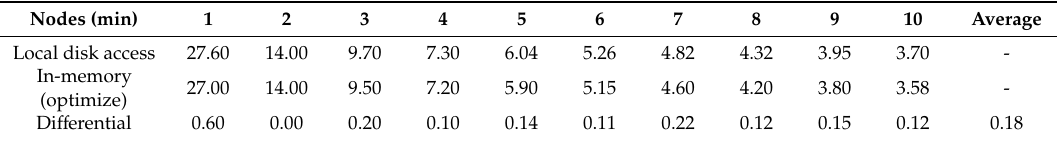
Table 6. Time consumption between whether applying disk access optimization strategy in PipeMEM. Nodes